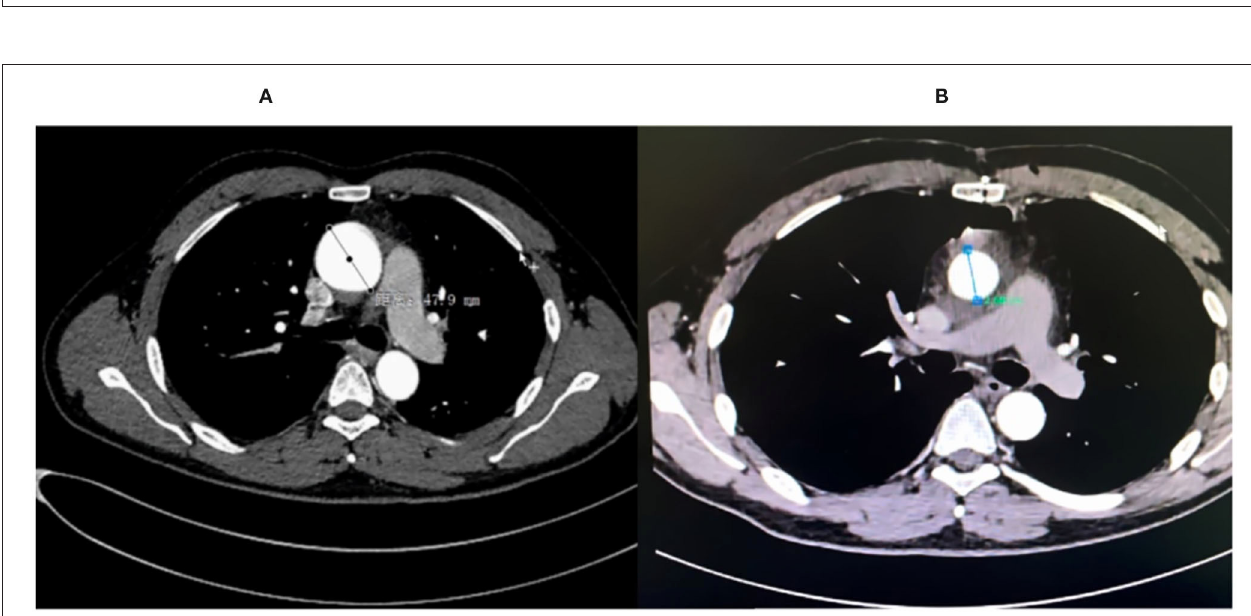
FIGURE 2 | (A) The pre-op CT angiography (CTA) showed ascending aortic aneurysm of 47.9mm. (B) The post-op CTA scan showed normal ascending aortic size.